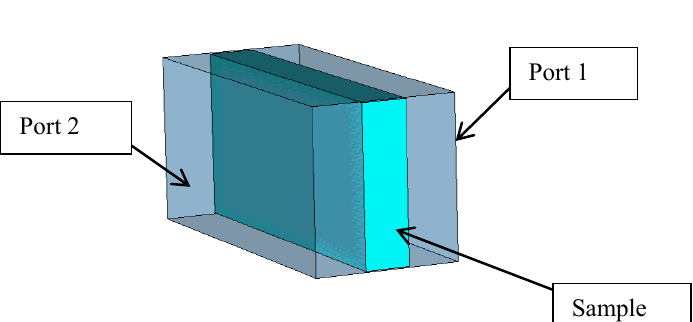
Fig. 2. 3D-model of the measuring